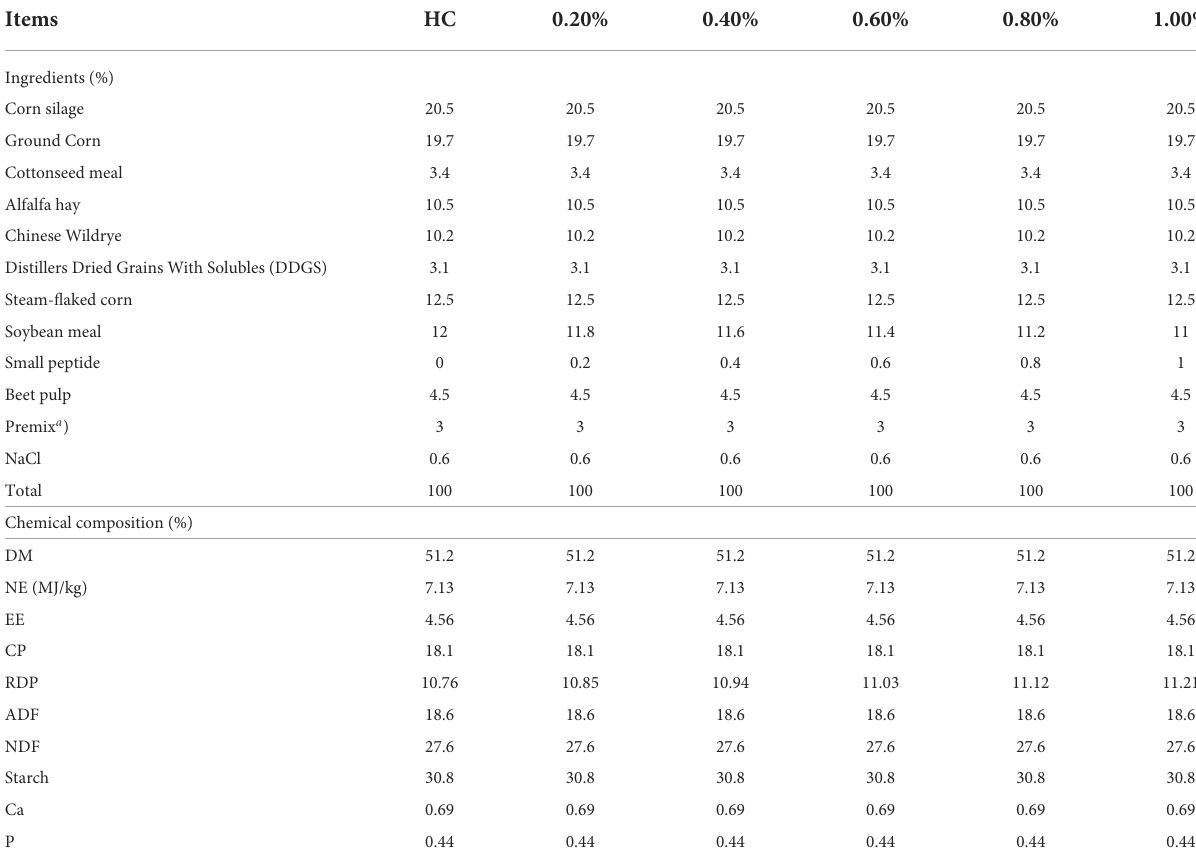
TABLE 1 Ingredients and chemical composition of the fermented substrates (dry matter